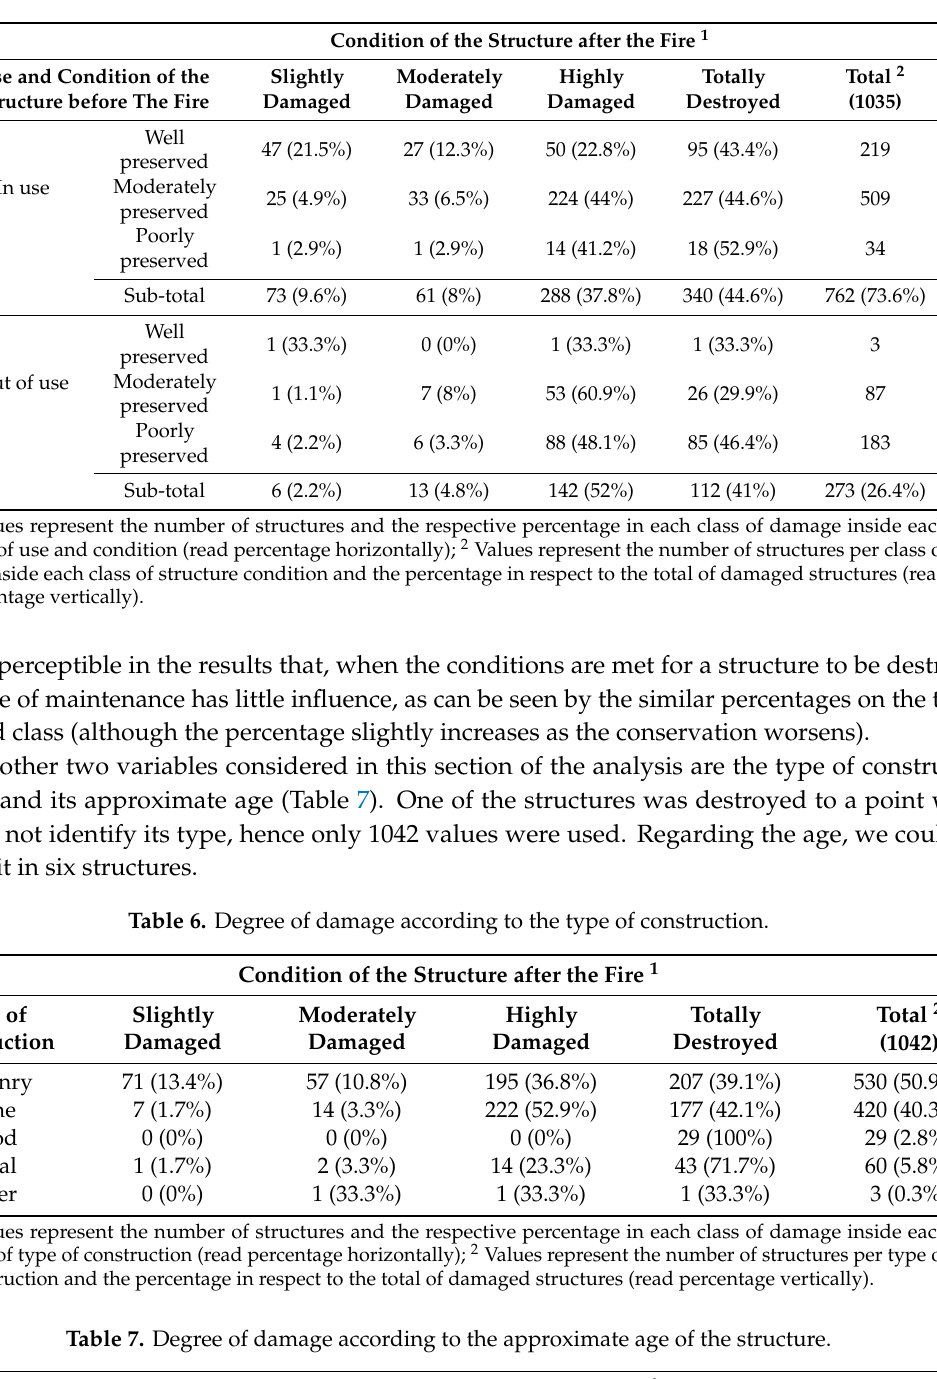
Table 5. Degree of damage according to the condition of the structure and the use of the structure before the fire.